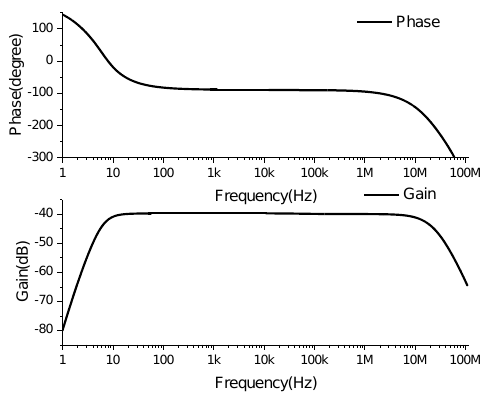
Figure 11. Rogowski transducer Bode diagram.